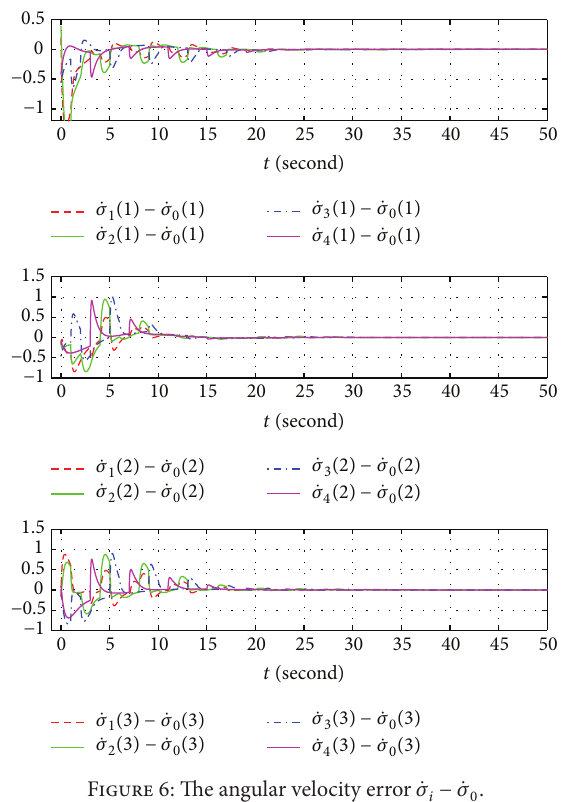
Figure 6: The angular velocity error ̇𝜎 𝑖 − ̇𝜎 0 .